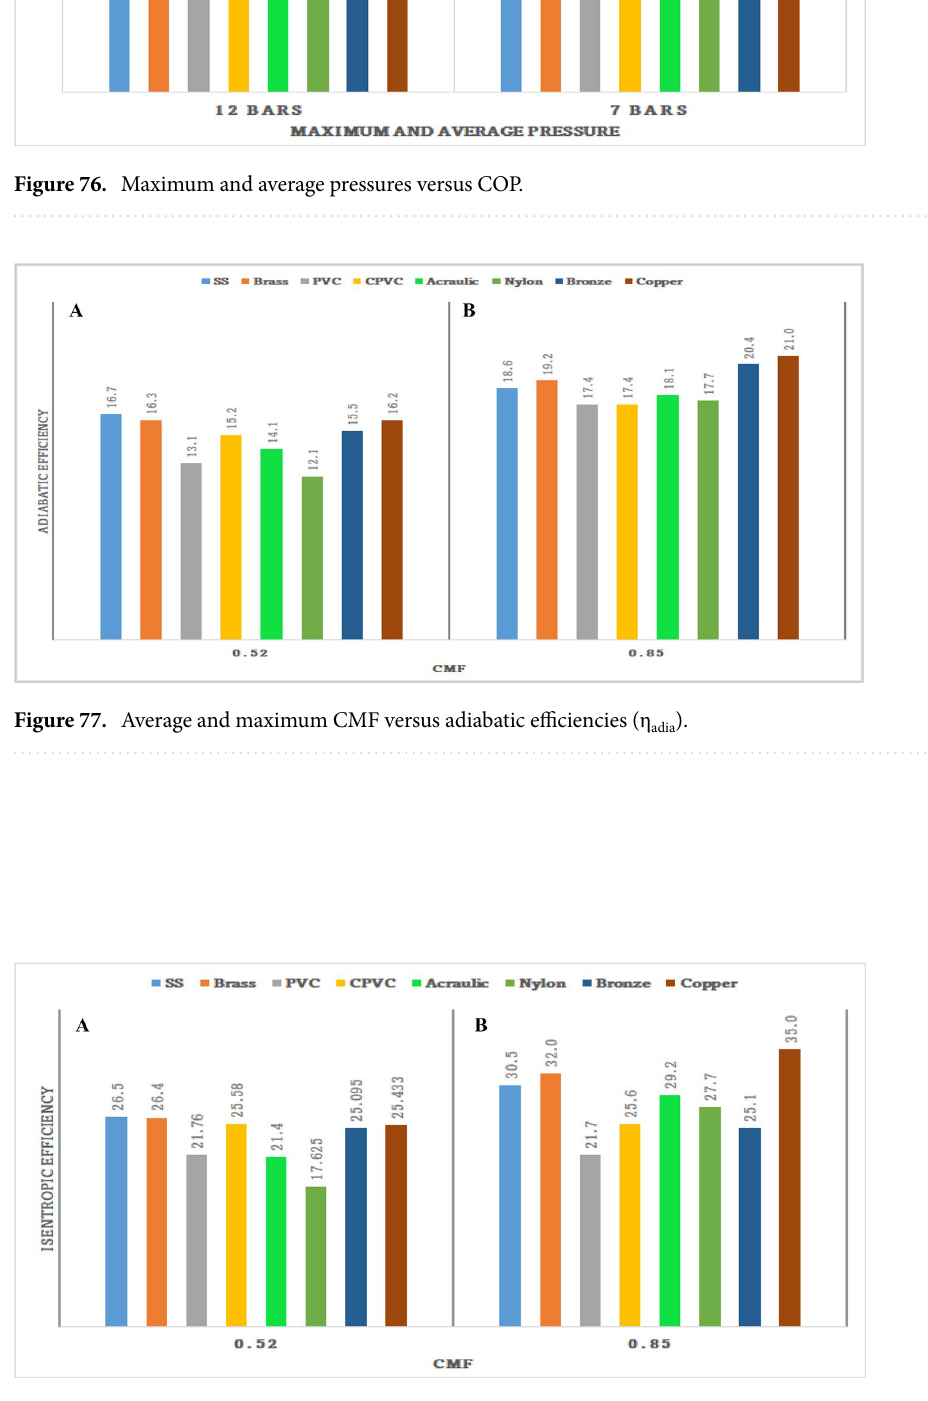
Figure 78. Average and maximum CMF versus isentropic efficiencies (η Isen